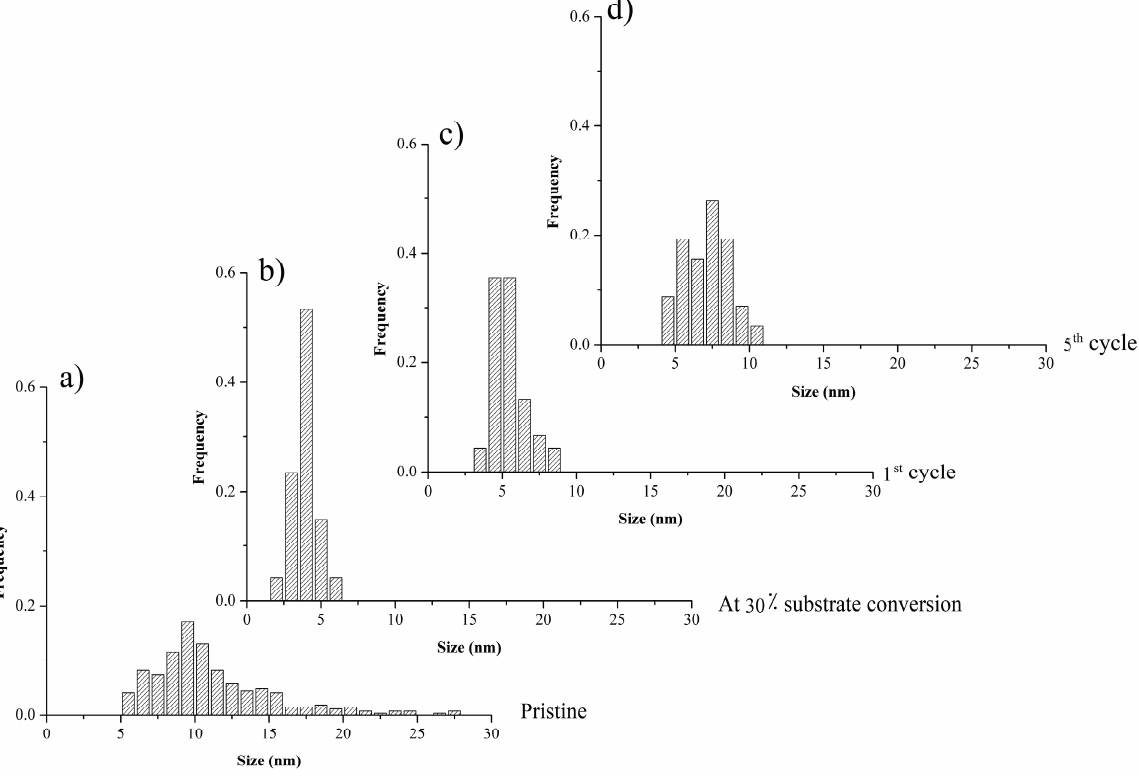
Figure 5. Pd NP size distributions in ( a ) pristine Pd-pol and in Pd-pol recovered after ( b ) 30 min; ( c ) the first cycle and ( d ) the fifth cycle of the Suzuki-Miyaura cross-coupling reaction described in entry 1 of Table